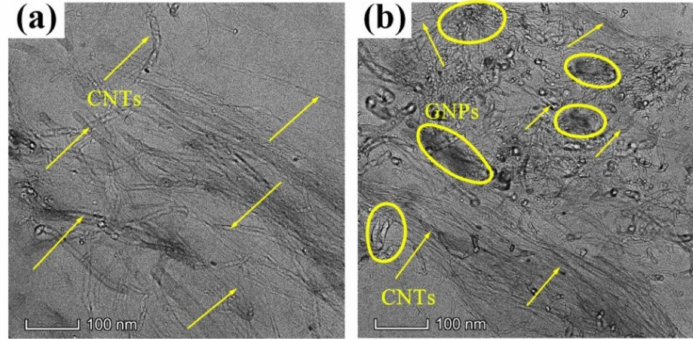
Figure 2. TEM images of CNT/GNP/EUG composites: ( a ) ECG0; ( b ) ECG3. The Payne effect is widely used to characterize filler dispersion and filler